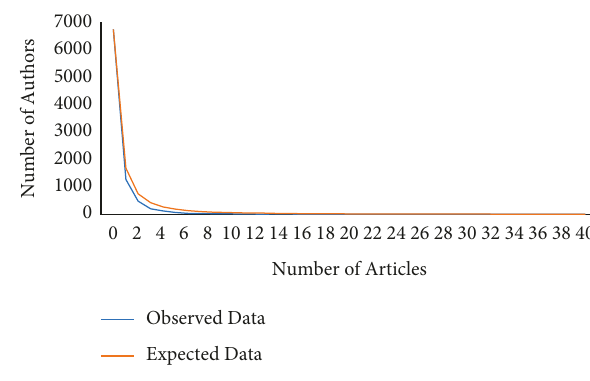
Figure 6: The frequency distribution of scientific